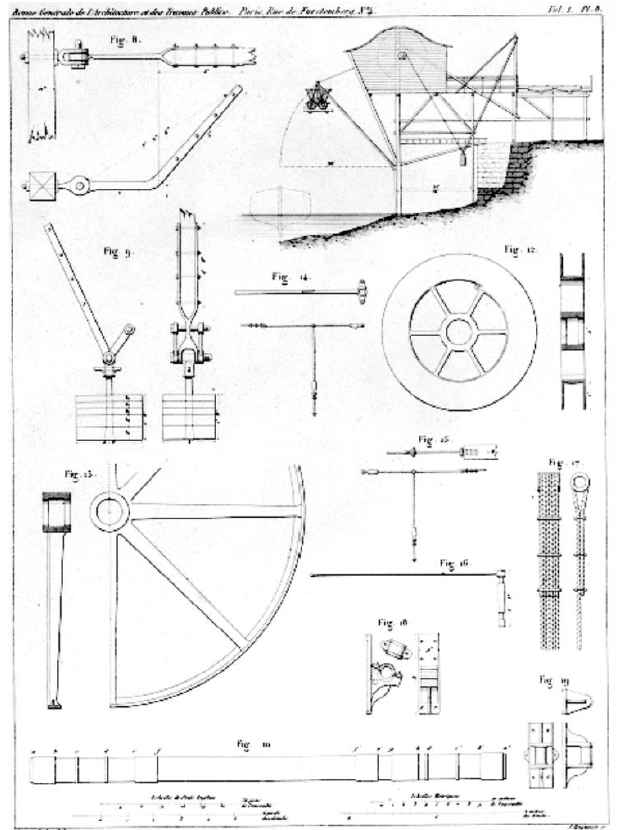
Figure 33. Details of machinery used to ship coal in England. Engraving accompanying the article entitled “ Machines employed in England to ship coal ” signed by Teisserenc, published in the journal “ Revue Générale de l ’ architecture et des Travaux Publics ” , France, 1840. Vol. 1, (Pl. 8). Reference [60].